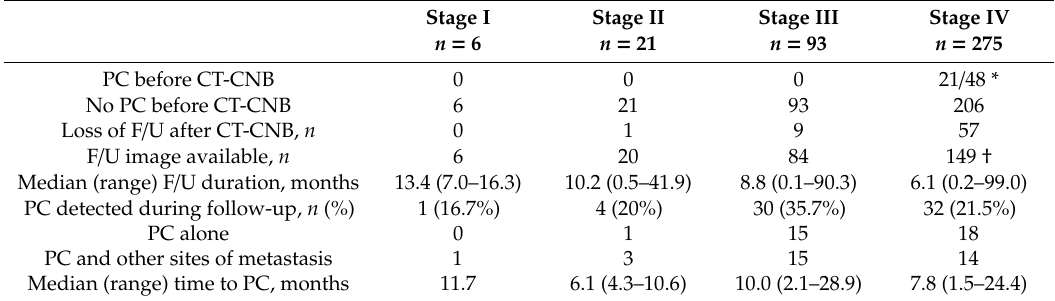
Table 5. Incidence of peritoneal carcinomatosis at diagnosis and during